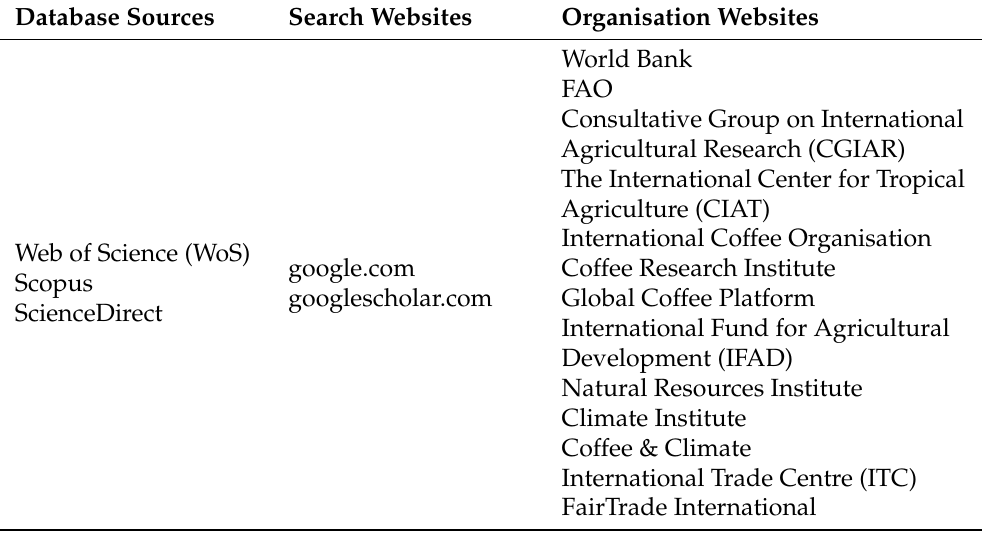
Table 4. List of academic database sources and websites